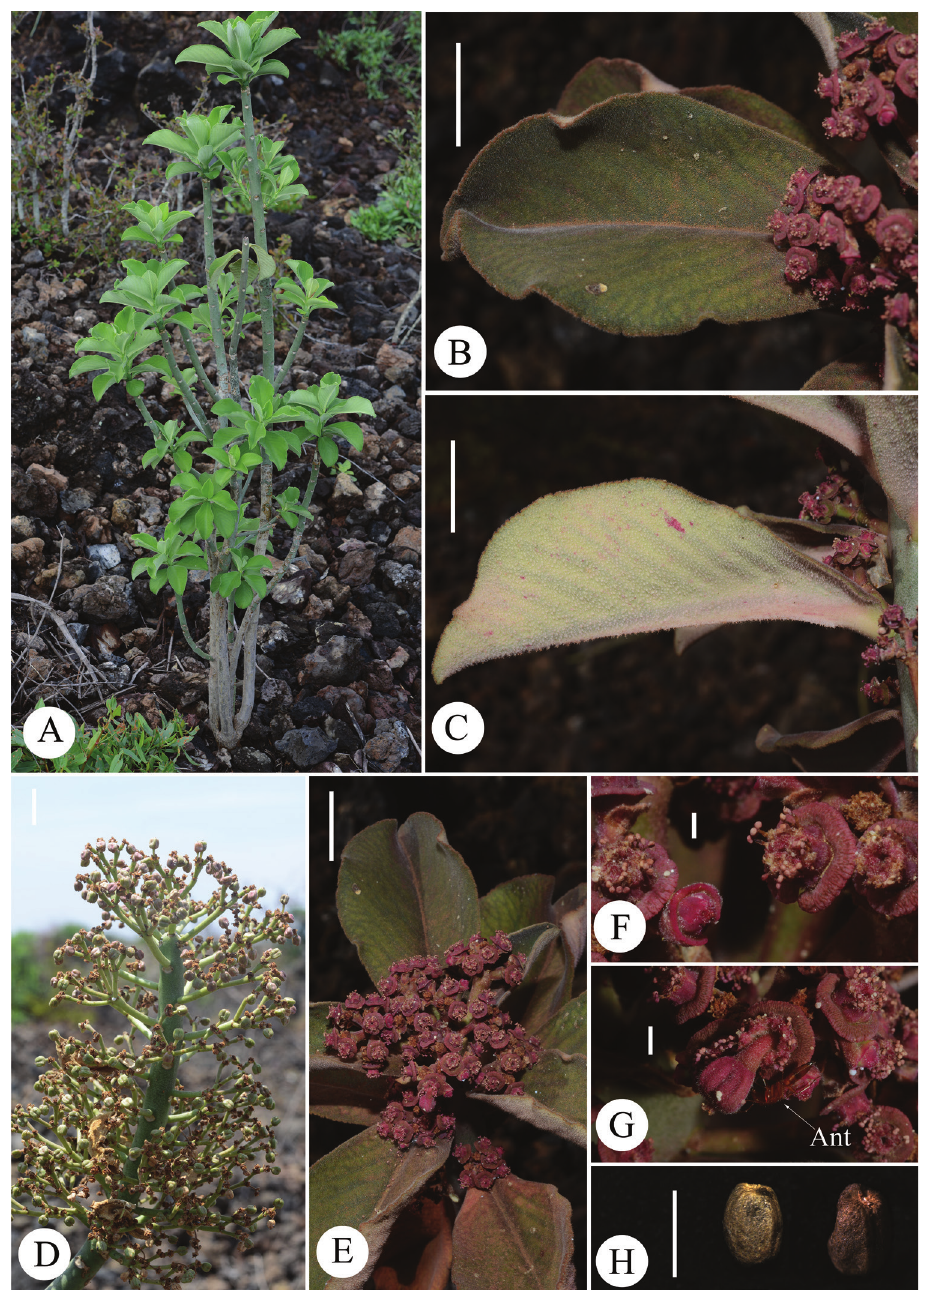
Figure 3. Morphological features of Euphorbia mbuinzauensis A habit B adaxial surface of leaf C abax- ial surface of leaf D a branch with numerous infructescences E apical portion of flowering branch F, G Cyathium H seeds. Scale bars: 2 mm ( F–H ); 2 cm ( B–E ). Voucher specimens: SAJIT 007411 ( A ), SAJIT 007200 ( B–H ). Photo credit: Neng